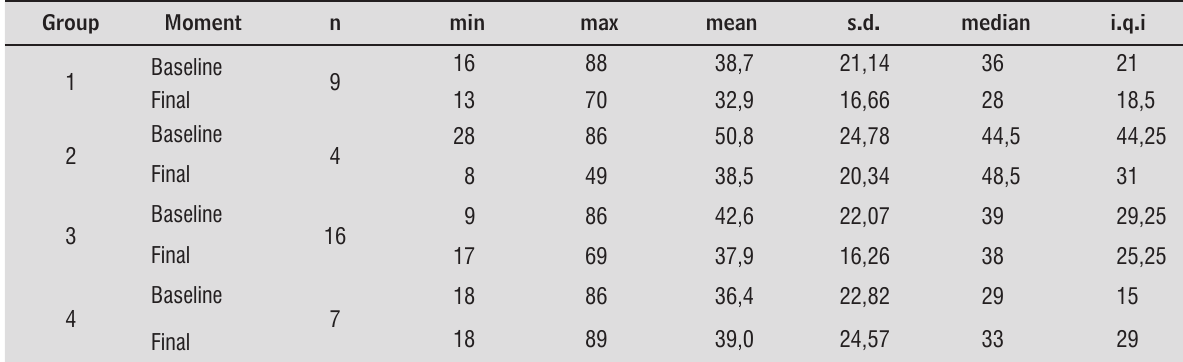
Table 2 - Statistical description of UPDRS scores